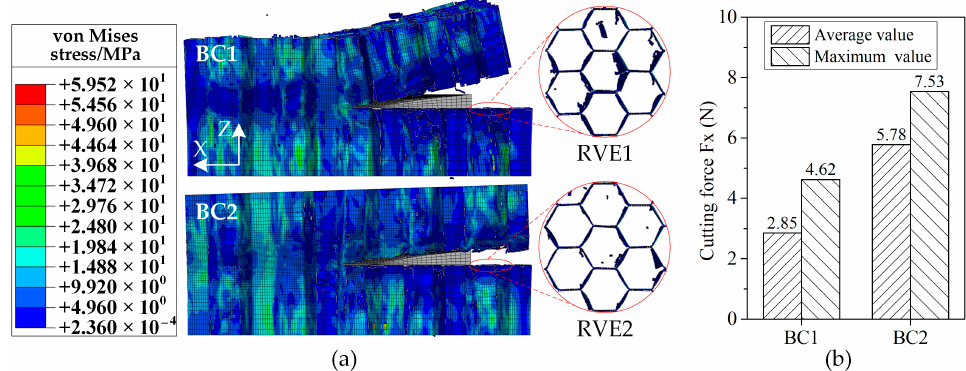
Figure 10. Predicted stress distributions and cutting forces under different specimen boundary conditions: ( a ) predicted stress distributions; ( b ) predicted cutting forces.